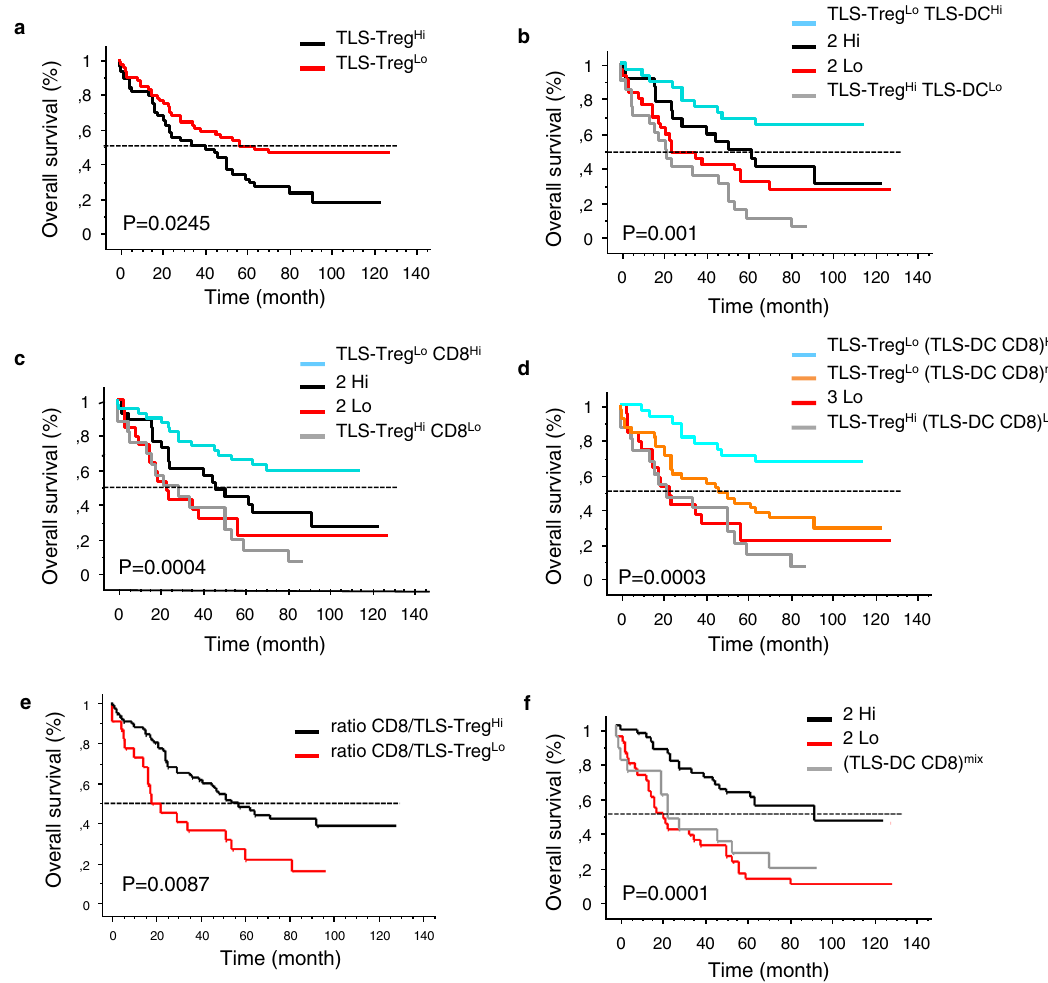
Fig. 9 Kaplan-Meier curves for TLS-Tregs alone or in combination with TLS-DC and/or CD8 + T cells. Densities of total Tregs, TLS-mature DC, and CD8 + T cells were determined by IHC using serial sections of FFPE lung tumor samples. The Kaplan – Meier survival graphs were plotted for the determination of the percentage OS of the patients. The Log-rank test was used to determine the statistical signi fi cance of the data. Overall survival of NSCLC patients according to densities of a TLS-Tregs, b TLS-Tregs TLS-DC, c TLS-Tregs CD8, d TLS-Tregs (TLS-DC CD8), e total CD8-to-TLS-Tregs ratio, f TLS-DC